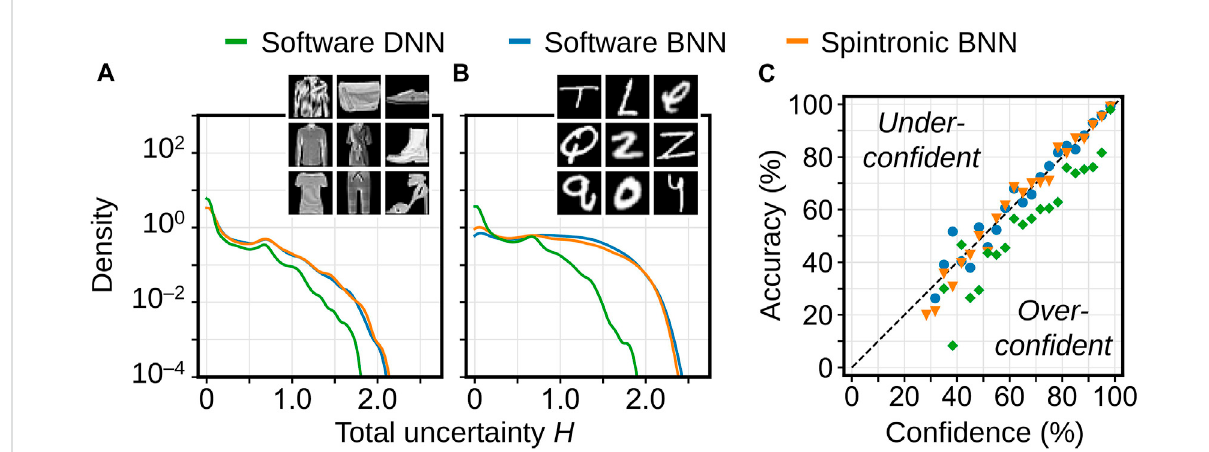
FIGURE 4 Distribution of predicted uncertainty (kernel density estimation) by the software DNN, software BNN, and BNN simulated on spintronic hardware, on (A) the Fashion MNIST test set, and (B) the EMNIST-Letters test set. Both the DNN and BNN were trained on Fashion MNIST. Uncertaintiesareinunitsofinformationentropy. (C) UncertaintycalibrationcurveofthethreecasesontheFashionMNISTtestset.Notethatmostof the predictions lie in the highest con fi dence bands.